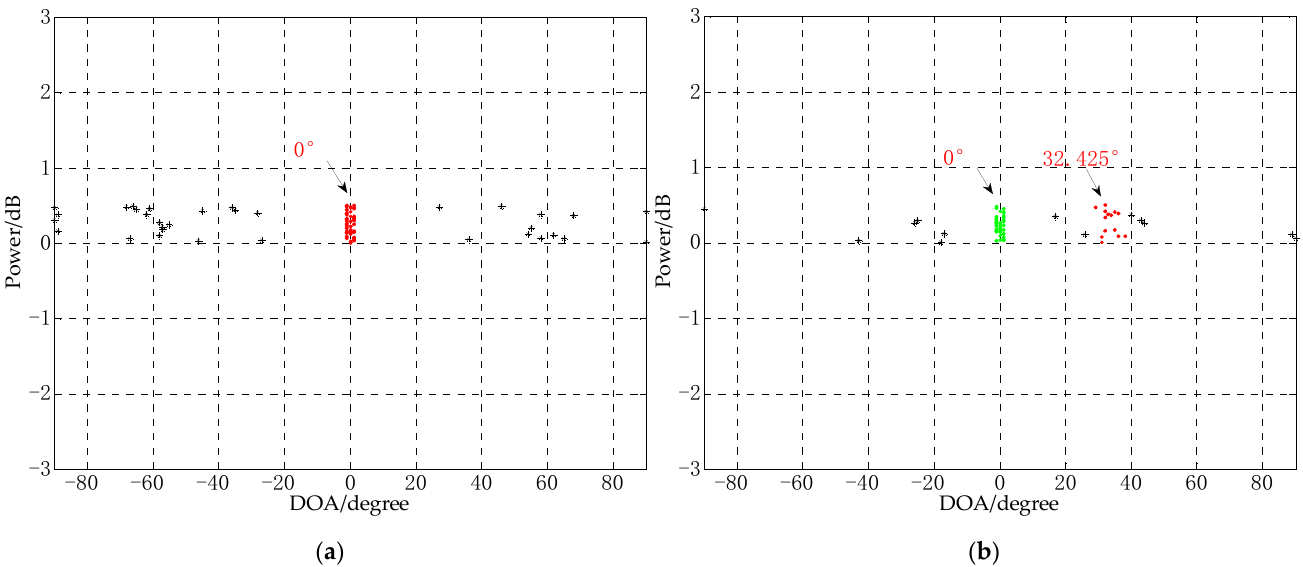
Figure 22. DOA estimation results. ( a ) DOA estimation of the stationary signal before the shock wave. ( b ) DOA estimation of the signal near the shock wave.